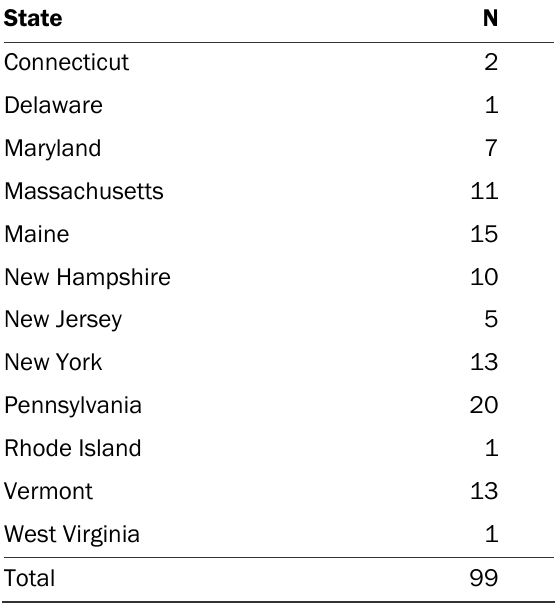
Table 1. Survey Responses by